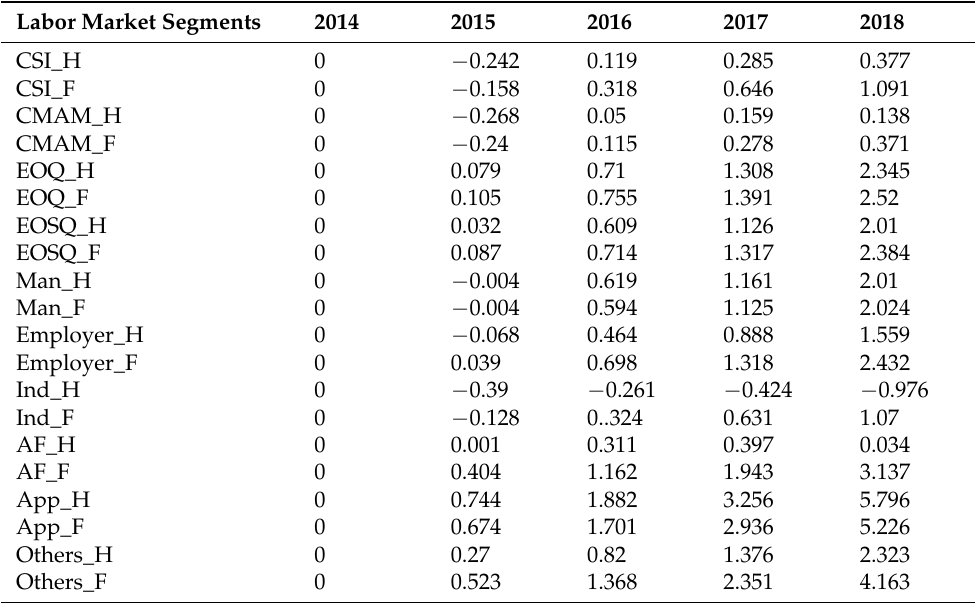
Table 2. Evolution of the wage rate according to the labor market segments (in % compared to the